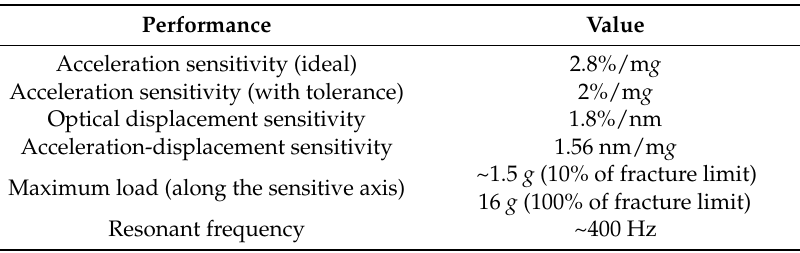
Table 4. Performance of our scheme